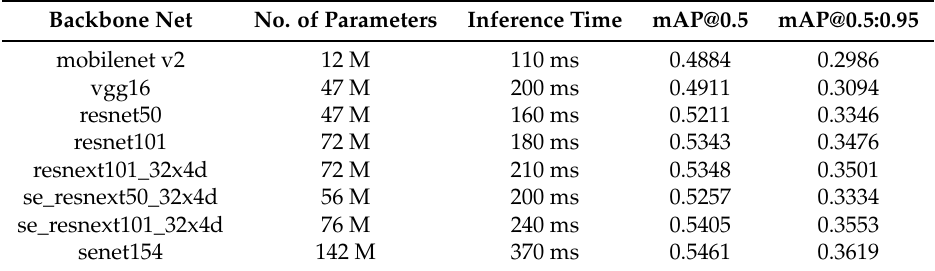
Table 1. Benchmark of different backbone network trained on COCO dataset.